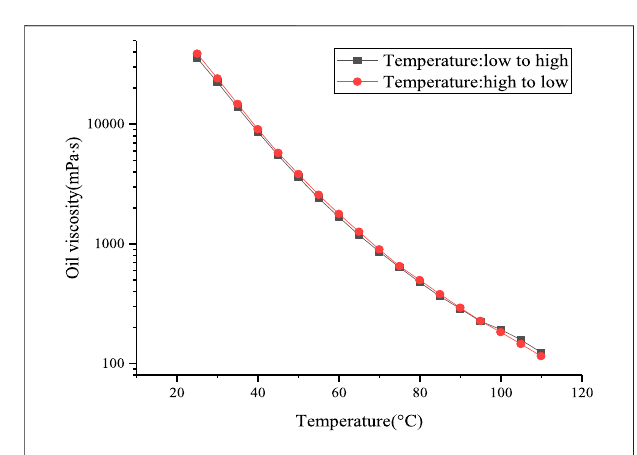
FIGURE 1 | Viscosity – temperature curve of heavy